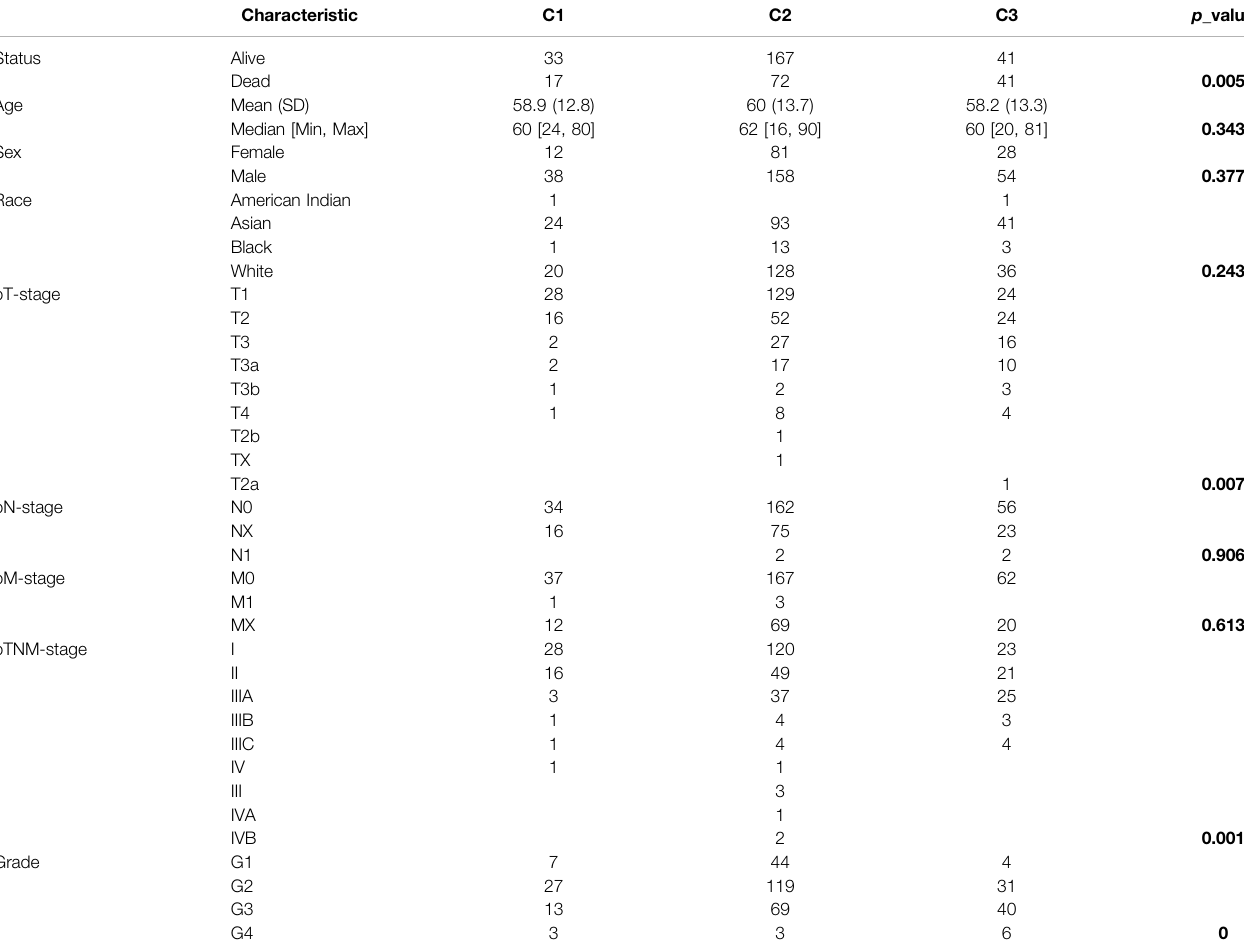
TABLE 1 | Correlations between different clinicopathological parameters and the three clusters in HCC. The p-values are shown in bold.